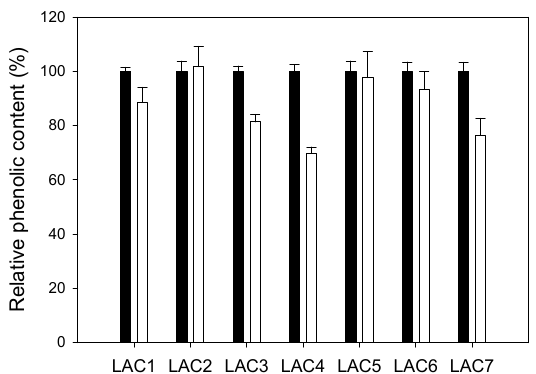
Figure 5. Relative phenolic content in DP401 lignosulfonate before (black bars) and after 24 h-treatment with 20 µL supernatants from S. cerevisiae microcultures secreting the different engineered laccase variants (white bars). Error bars indicate standard deviation for three replicates.